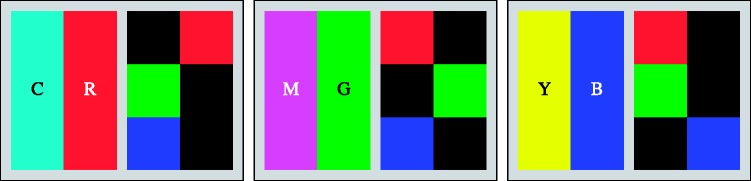
The case of simultaneous edges in all three RGB colour channels, in which case there will be no overlay. Here, the difference is in the polarity of the edges.